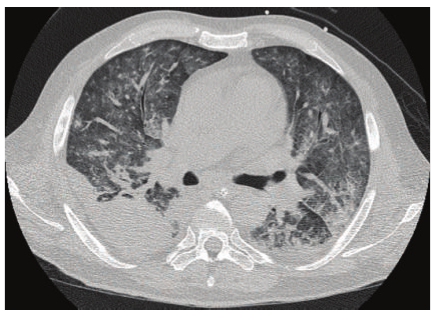
Figure 2: Chest CT scan demonstrating diffuse ground glass opacification with consolidation and pleural effusion. On autopsy, the lungs showed evidence of haemorrhagic infarction in keeping with the CT appearance.